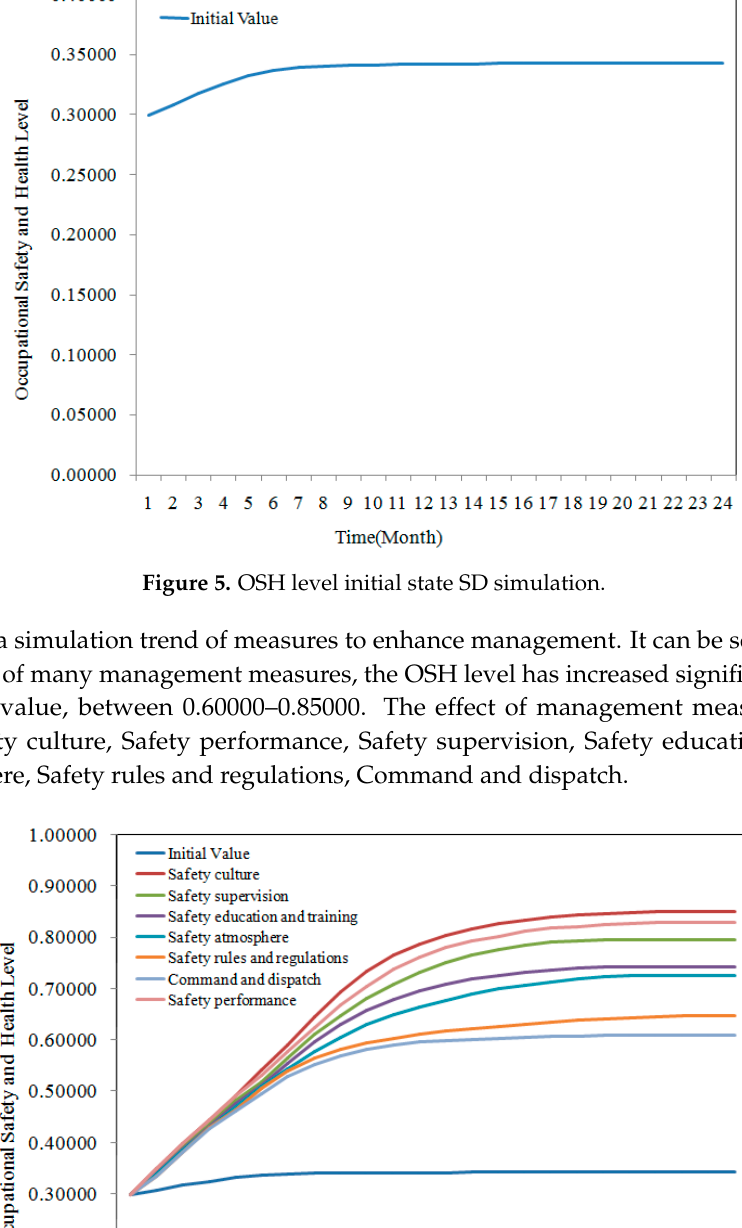
Figure 7. SD simulation of human factor measures.